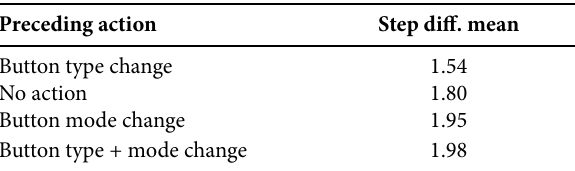
Table 5: Step difficulty means for direct interaction with the model, depending on the preceding action